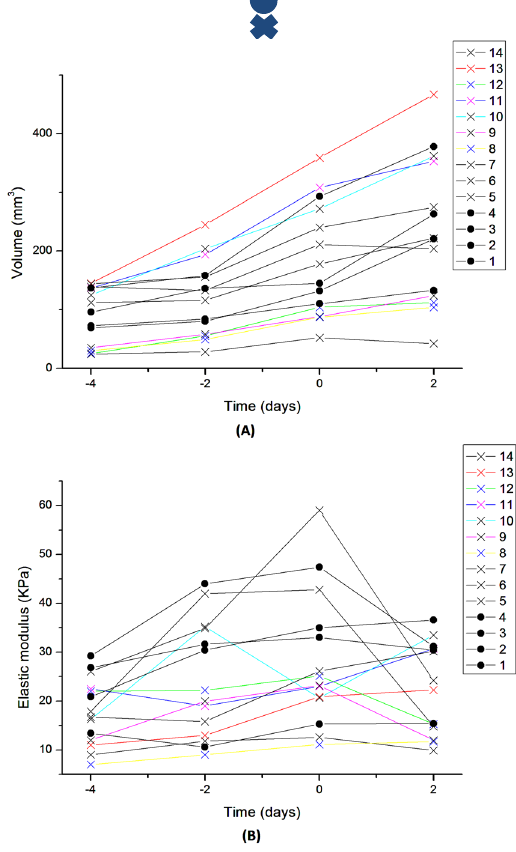
Figure 4. Tumour volume and elastic modulus comparison. Temporal change in tumour volume ( A ) and tumour elasticity ( B ). Day 0 corresponds to the point of treatment. Filled circles indicate control group and crosses indicate treated